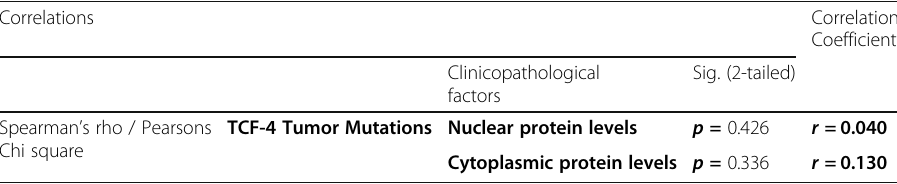
Table 7 Effect of Gene mutations on TCF-4 Protein Expression Levels